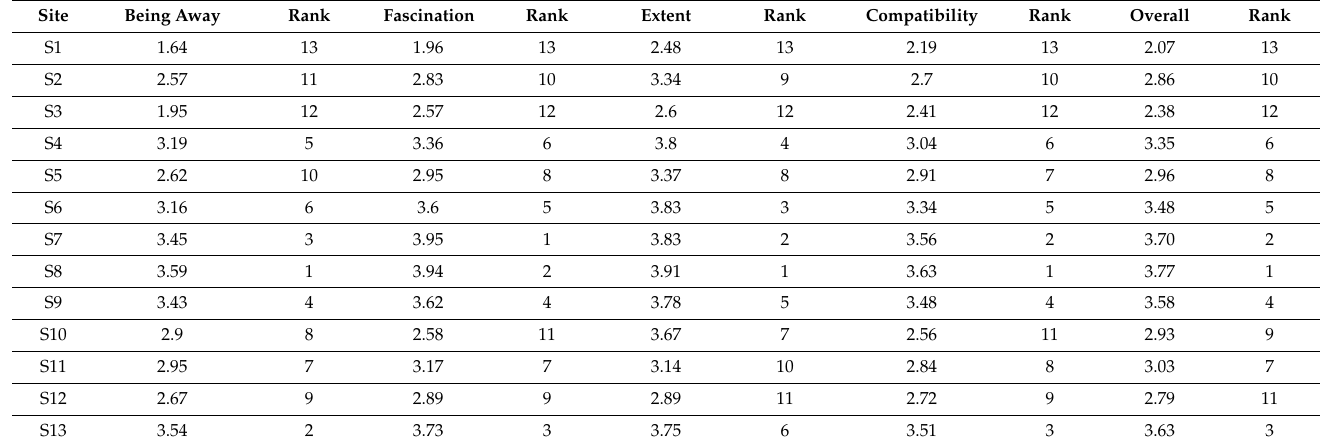
Table 4. Results of the assessment of psychological restoration using the Perceived Restorativeness Scale. Site